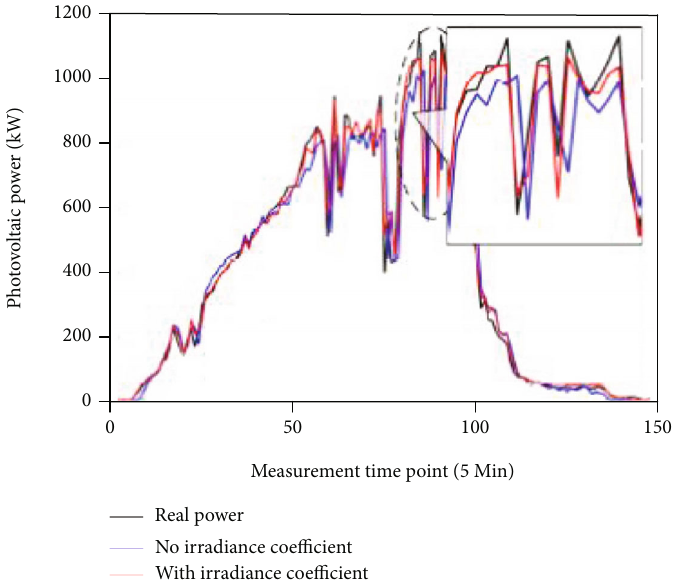
Figure 18: Comparison of the output power with and without irradiance coe ffi cient.